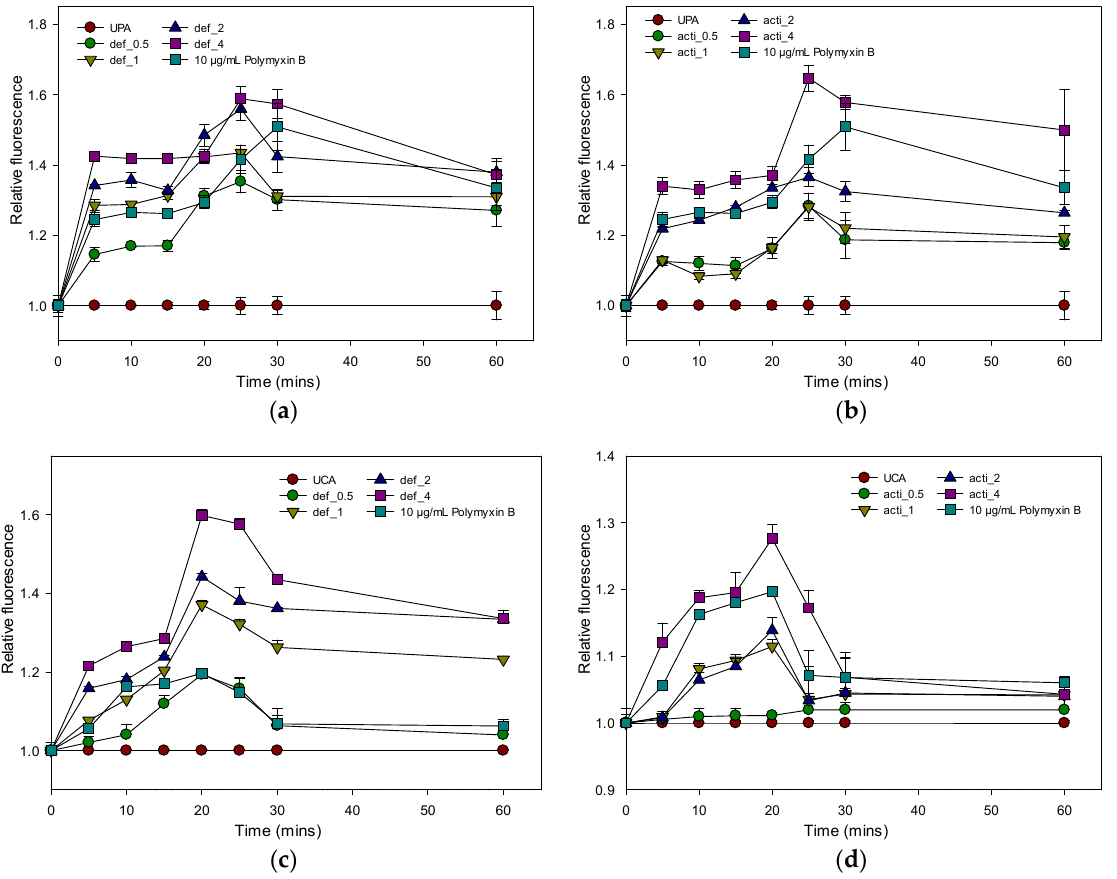
Figure 11. Relative fluorescence of NPN uptake to assess outer-membrane permeability of recombi- nant defensin-d2 and actifensin against P. aeruginosa and C. albicans . ( a ) defensin-treated P.